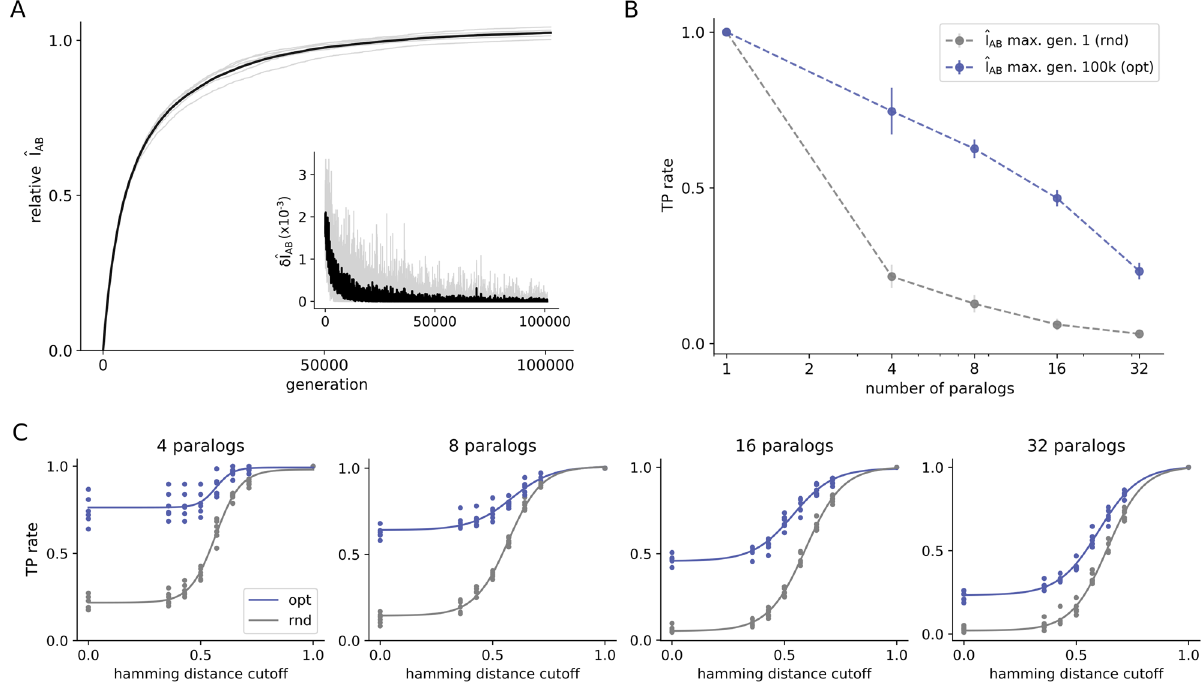
Figure 6. Evaluation of optimized MSA concatenations of the HK-RR paralogs dataset. ( A ) Optimization trajectories for the HK-RR standard dataset. The interface mutual information normalized by the native interface mutual information (relative ˆ I AB ) is plotted against the number of generations for optimizations (in blue) solutions after ~ 100,000 rounds of ˆ I AB maximization. The TP rate is shown in average for